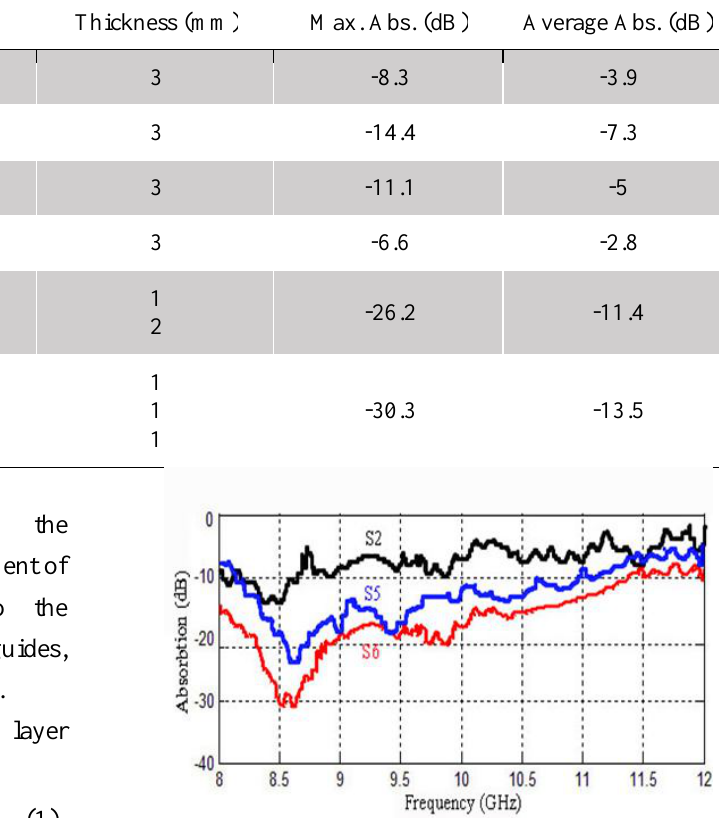
Fig. 4. Radar absorbtion spectra of S2, S5 and S6